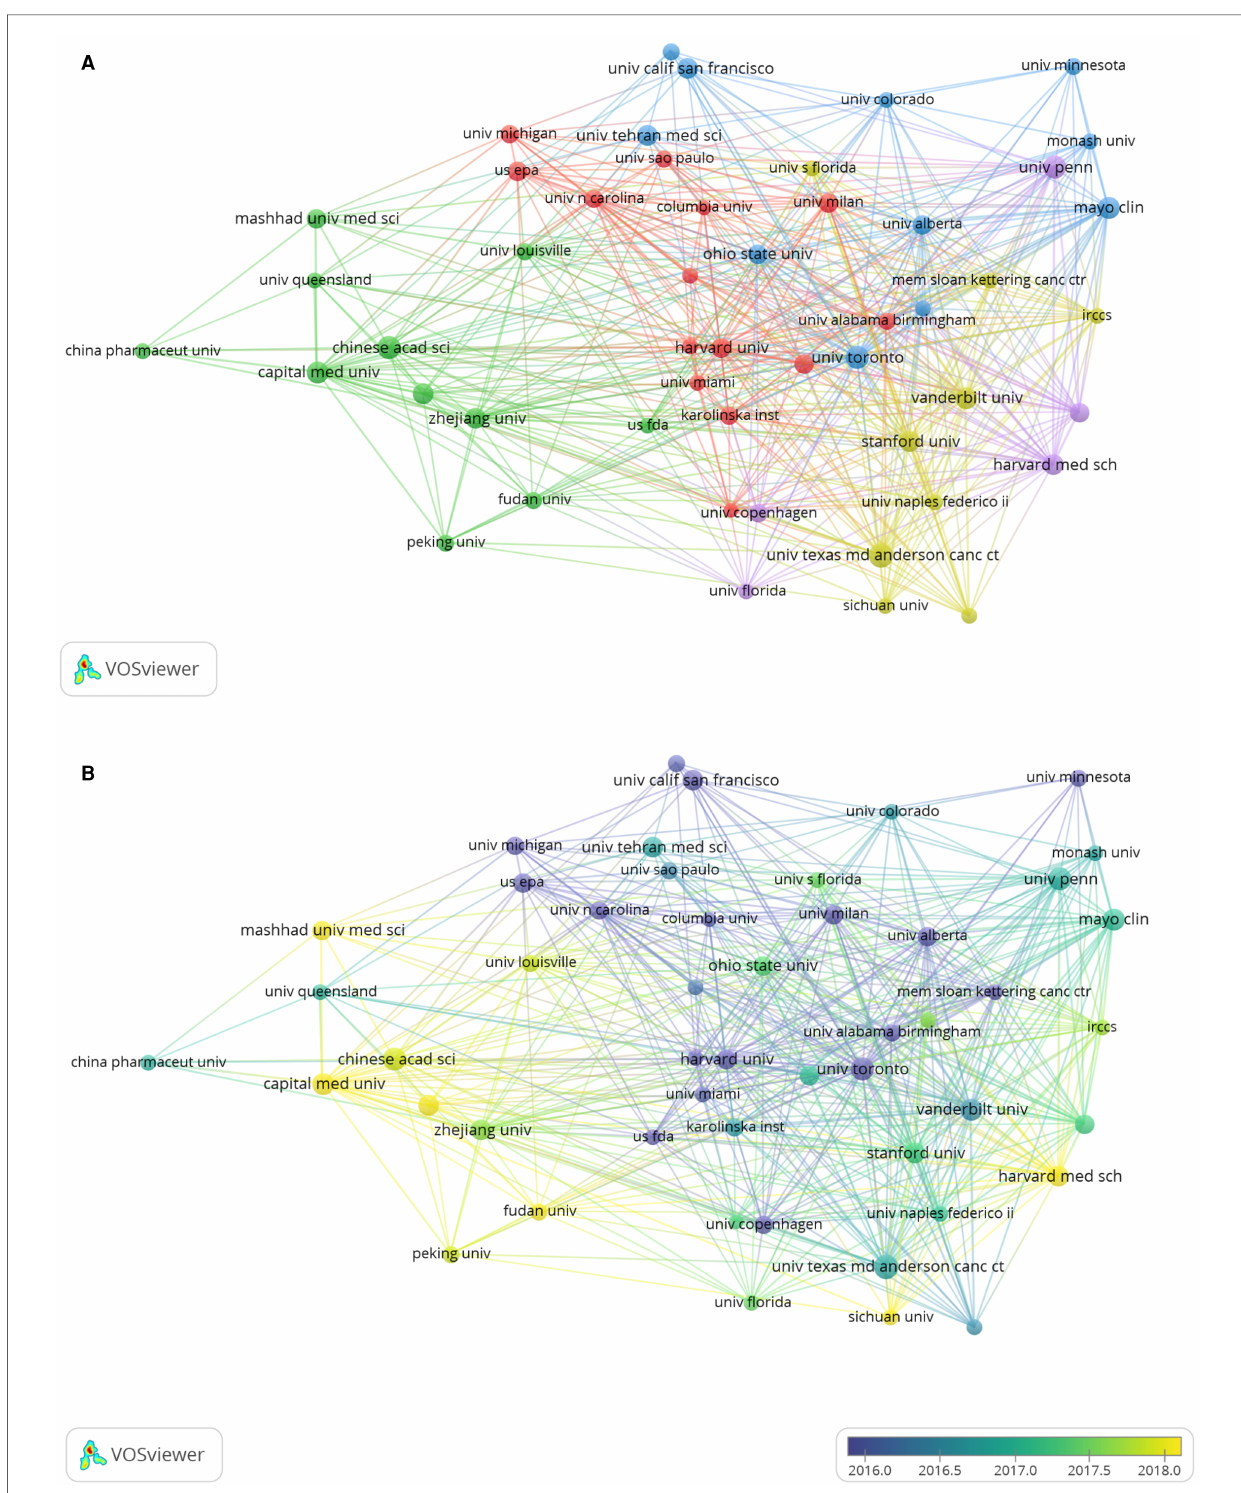
FIGURE 3 ( A ) network map of institution collaboration analysis based on VOSviewe. ( B ) Network map of institution collaboration analysis based on VOSviewer. Each node represents a different institution, and the node size is proportionate to the quantity of publications produced by that institution. The distance between two nodes indicates the relatedness of their collaboration link, and a smaller distance implies a stronger correlation of their relatedness. The thickness of the connecting line between nodes indicates link strength of a collaboration relationship, which could be weighted by a quantitative indicator, that is,